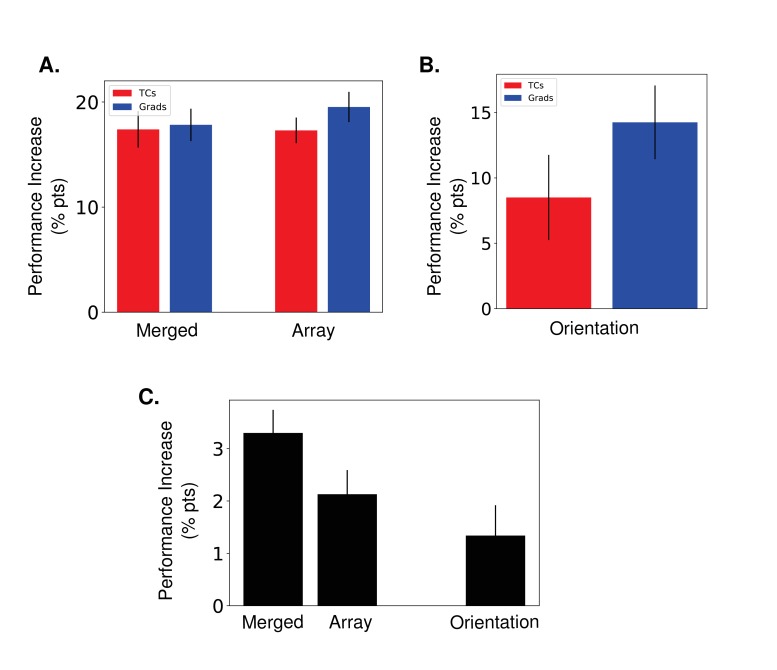
Effect of applying attention to all layers or all feature maps uniformly.(A) Effect of applying attention at all layers simultaneously for the category detection task. Performance increase in merged (left) and array (right) image tasks when attention is applied with tuning curves (red) or gradients (blue). Range of strengths tested is one-tenth that of the range tested when applying attention at only one layer and best-performing strength for each category is used. Errorbars are ± S.E.M. (B) Same as (A) but for orientation detection task (Figure 5A) (C) Control experiment. Instead of using tuning values or gradient values to determine how activity modulates feature maps, all feature maps are scaled by the same amount. Best-performing strengths are used for each category. These results show that merely scaling activity is insufficient to create the performance gains seen when attention is applied in a specific manner. Note: these results are independent of the layer at which the modulation takes place because [(1+β)∗Ilkij]+=(1+β)[Ilkij]+ if (1+β)>0.